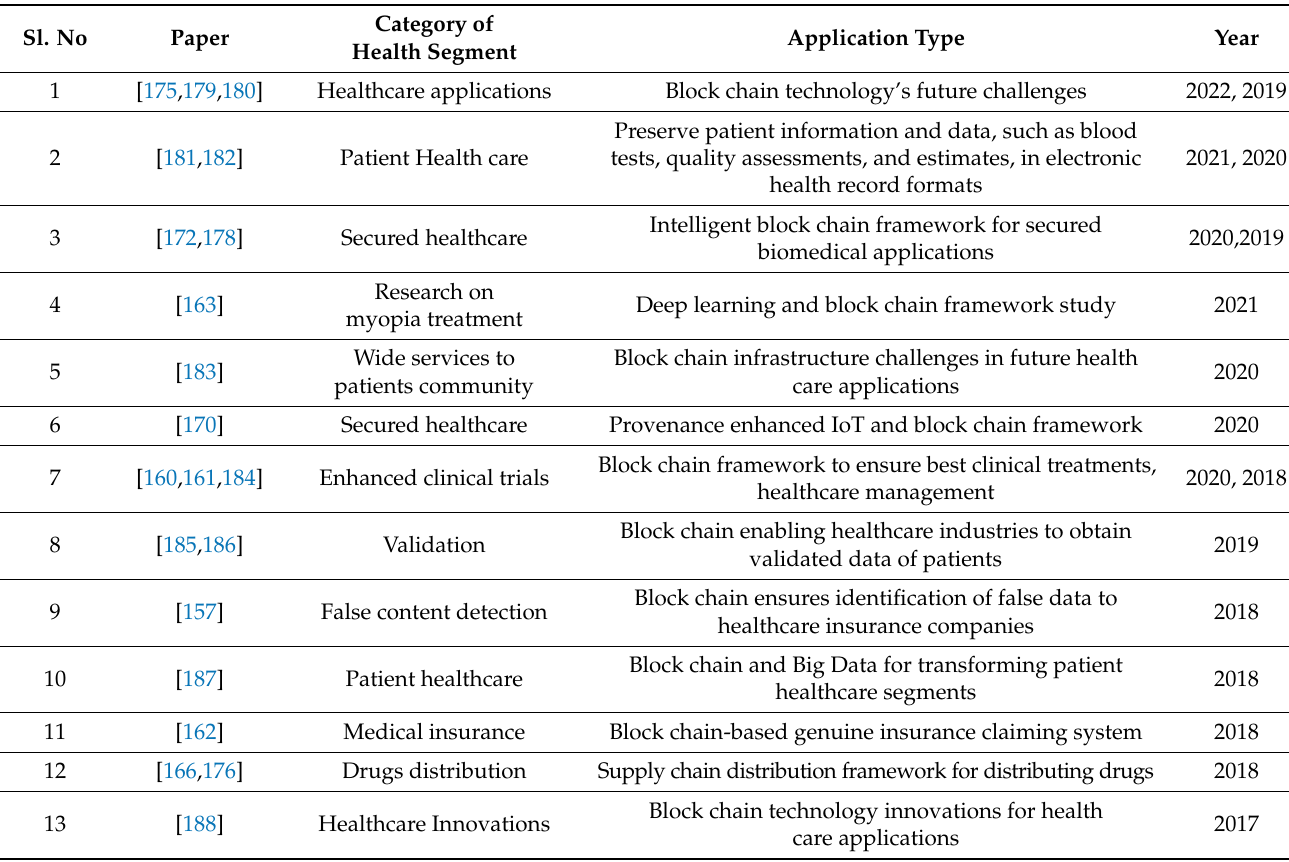
Figure 8. Block chain Technology for Healthcare Applications. Table 4. Review of Block Chain Technology in